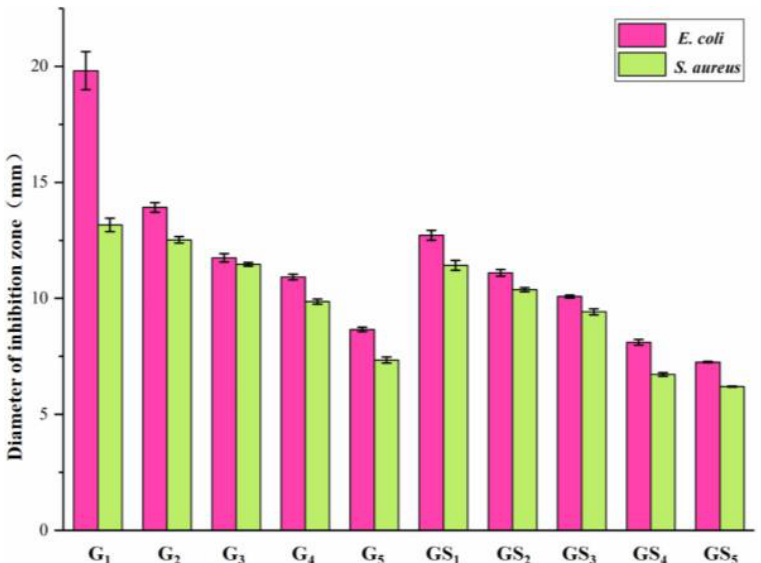
Figure 9. Inhibition zone diameter of purified compounds from DHP on E. coli and S. aureus.